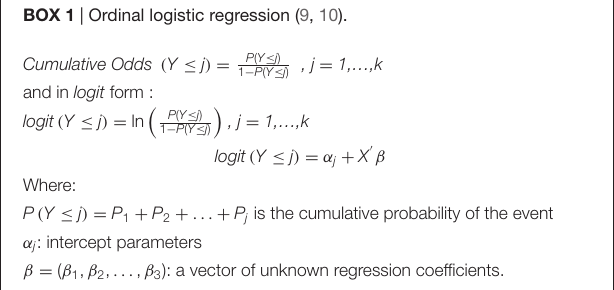
TABLE 1 | Characteristics of the study population: EPICARD